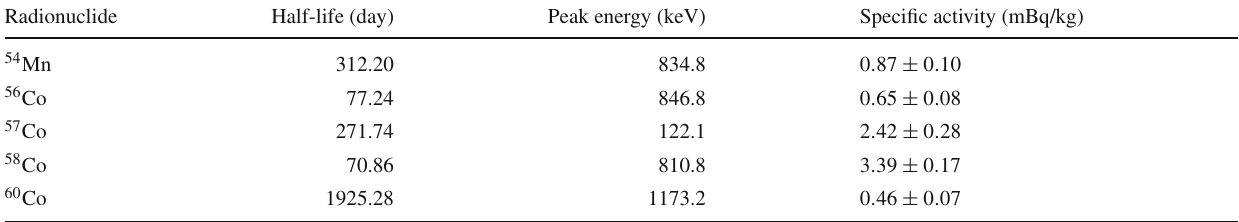
3 Cosmogenic activation in